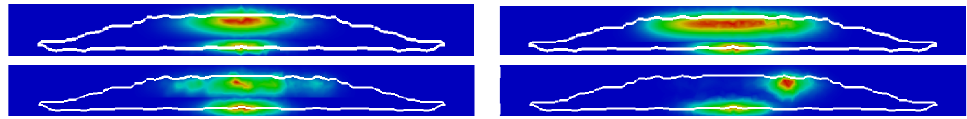
Figure 4. Simulations with three-dimensional models. ( Top ): GS for electrons and holes in the case of (cid:126) k · (cid:126) p for uniform In content ( left ) and VCA ( right ). ( Bottom ): GS for electrons and holes in the case of one RA configuration in the xz ( left ) and yz ( right )